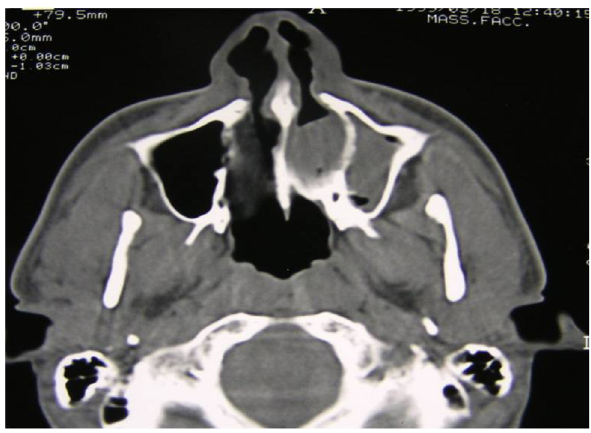
Axial CT scan, monolateral left bony choanal atre- sia.